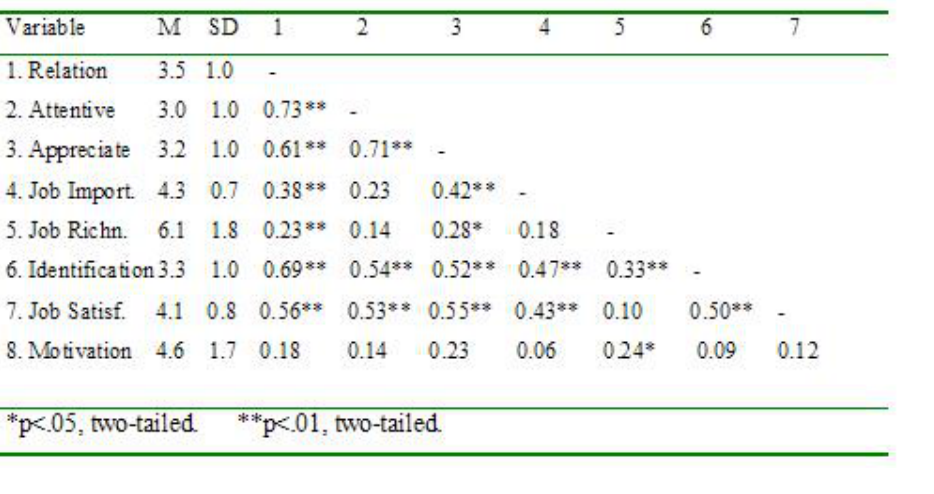
Table 1. Descriptive Statistics and Correlations for Study